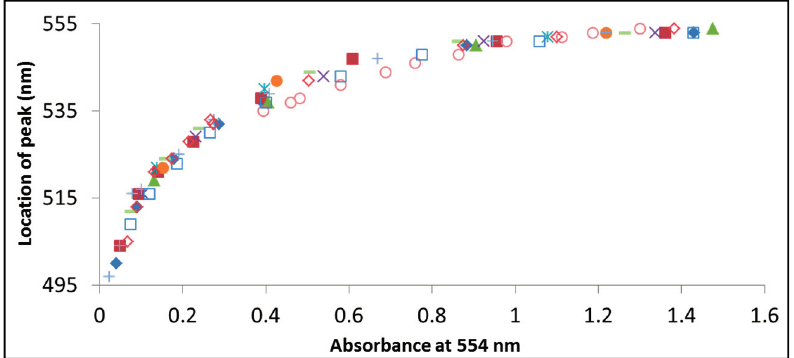
Figure 8. The location of the superimposed peak of rhodamine B and its intermediates during photodegradation by BiOCl versus the absorbption at 554 nm, which is the location of the RhB peak. Each symbol in the figure represents exposure at a different wavelength: 365 nm (filled diamonds), 375 nm (filled squares), 395 nm (filled triangles), 405 nm (× symbols), 410 nm (asterisks), 420 nm (filled circles), 435 nm (+ symbols), 470 nm (empty circles), 490 nm ( − symbols), 505 nm (empty squares), 515 nm (empty diamonds).